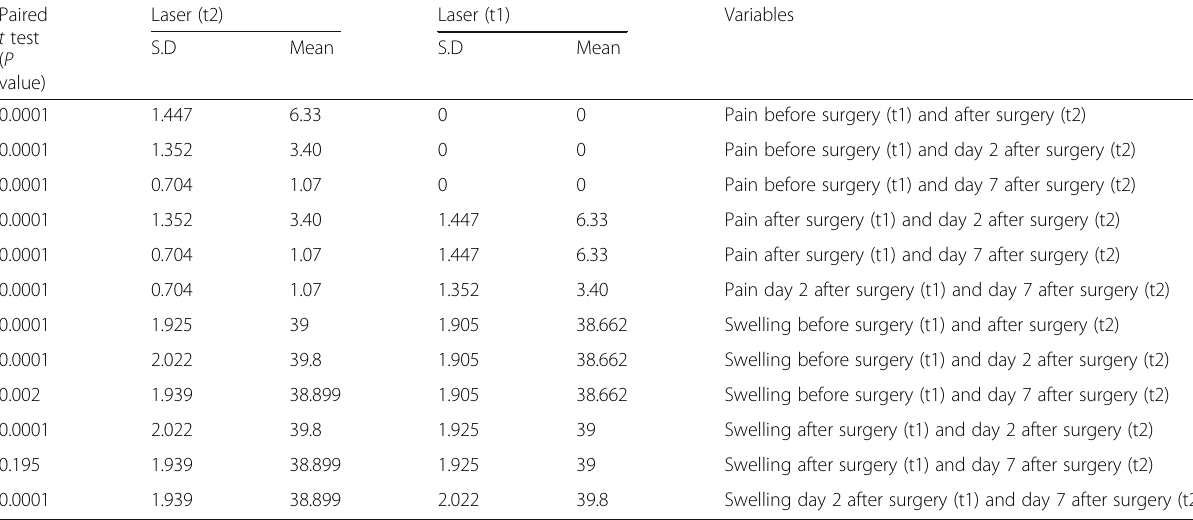
Table 7 Comparison of pain and swelling variables at different times of laser surgery Paired t test